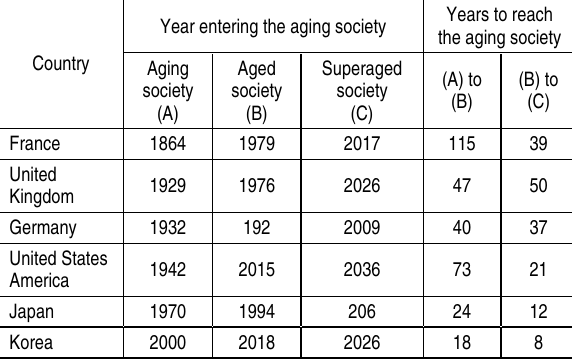
Table 1. International aging rate comparison among developed countries